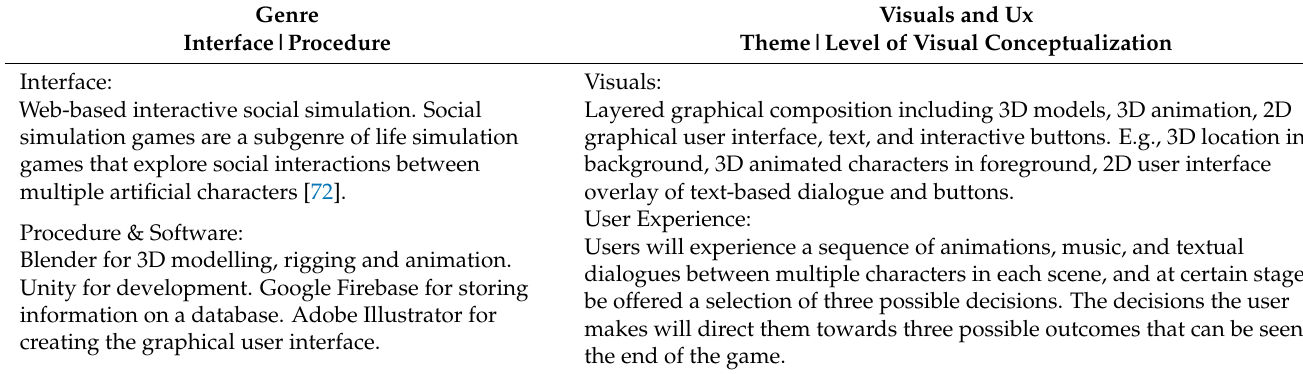
Table 6. Practical game